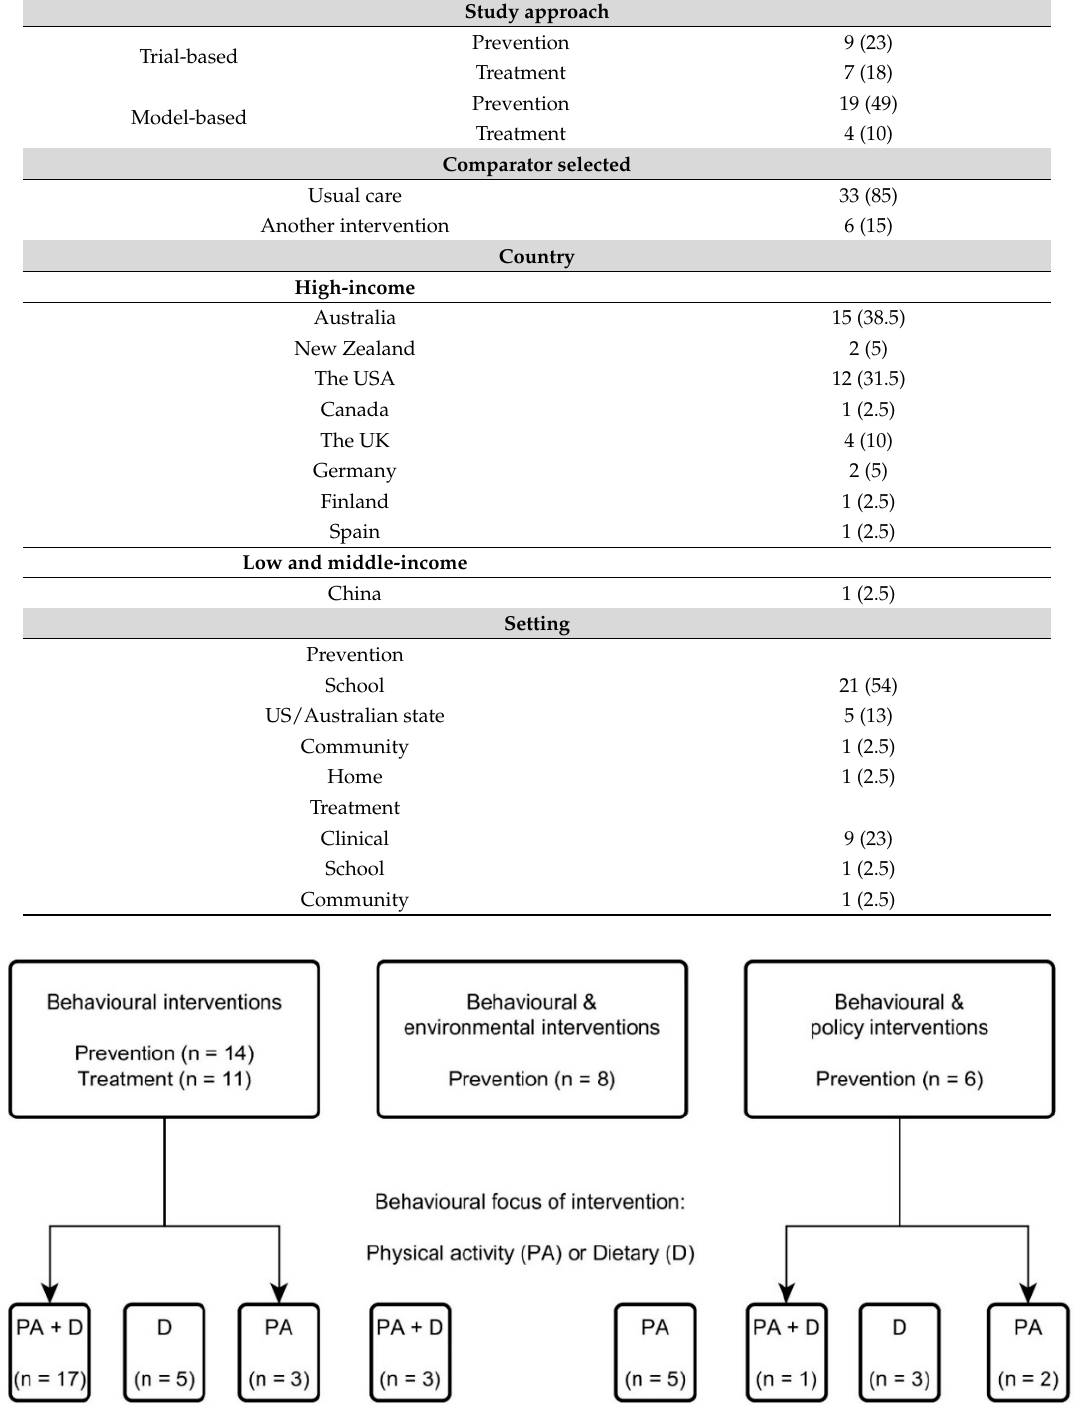
Table 1. Summary of general characteristics of the studies Study Characteristics